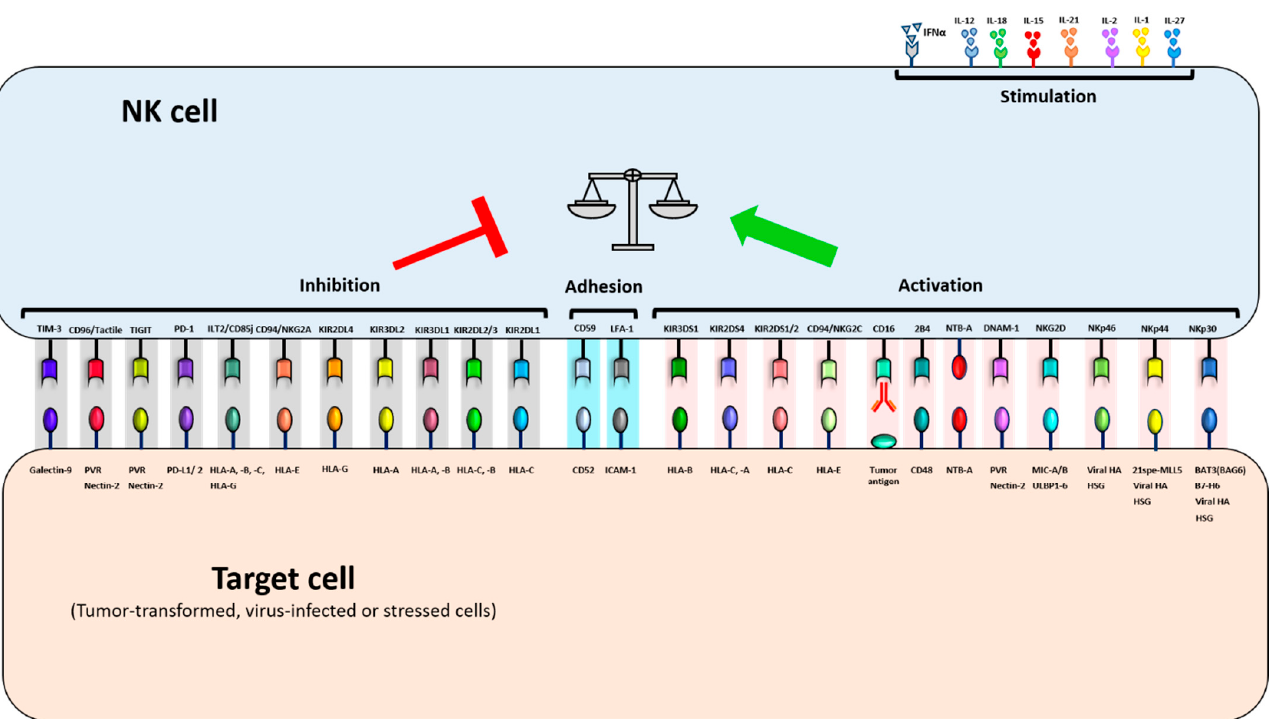
Figure 1. Receptor–ligand interactions regulating natural killer (NK) cell functions. Schematic representation of NK cell activity regulation by signals triggered by cell surface receptors. Activating and inhibitory receptors with their corresponding ligands, as well as adhesion molecules and receptors for stimulating cytokines, are shown.